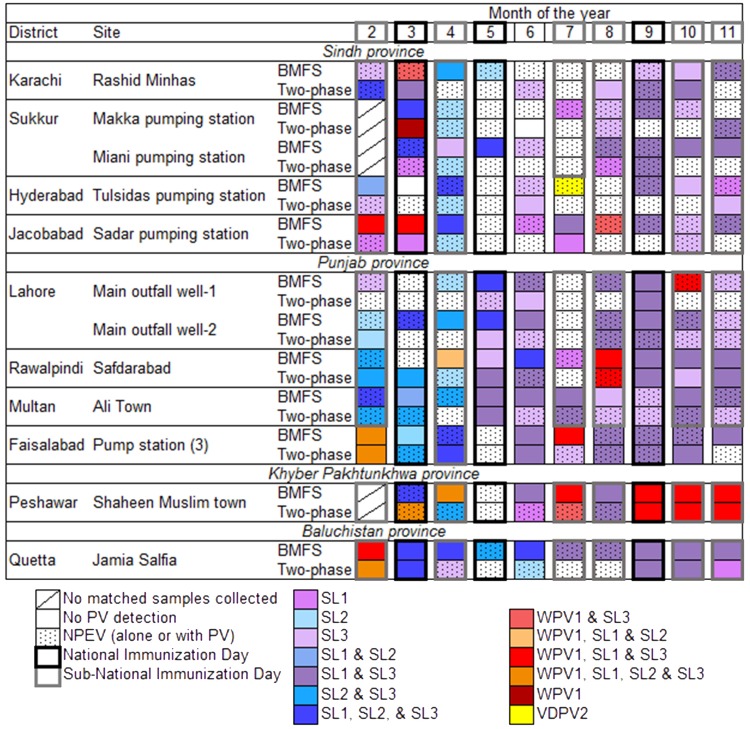
Detection of poliovirus (PV) in bag-mediated filtration system (BMFS) and two-phase samples from 12 study sites in 10 Pakistani districts from February-November 2016.NPEV is non-polio enterovirus. SL1 is Sabin-like poliovirus type 1. SL2 is Sabin-like poliovirus type 2. SL3 is Sabin-like poliovirus type 3. WPV1 is wild poliovirus type 1. VDPV2 is vaccine-derived poliovirus type 2.